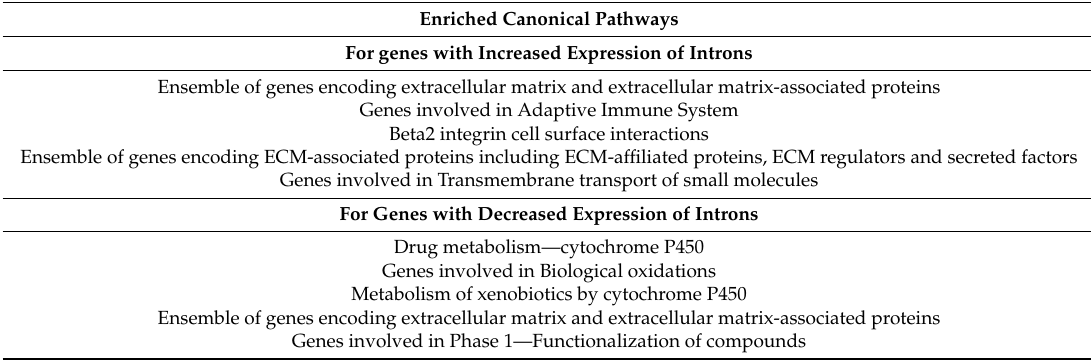
Table 5. Top 5 enriched pathways for the genes with differentially expressed introns after Vitamin E supplement treatment.